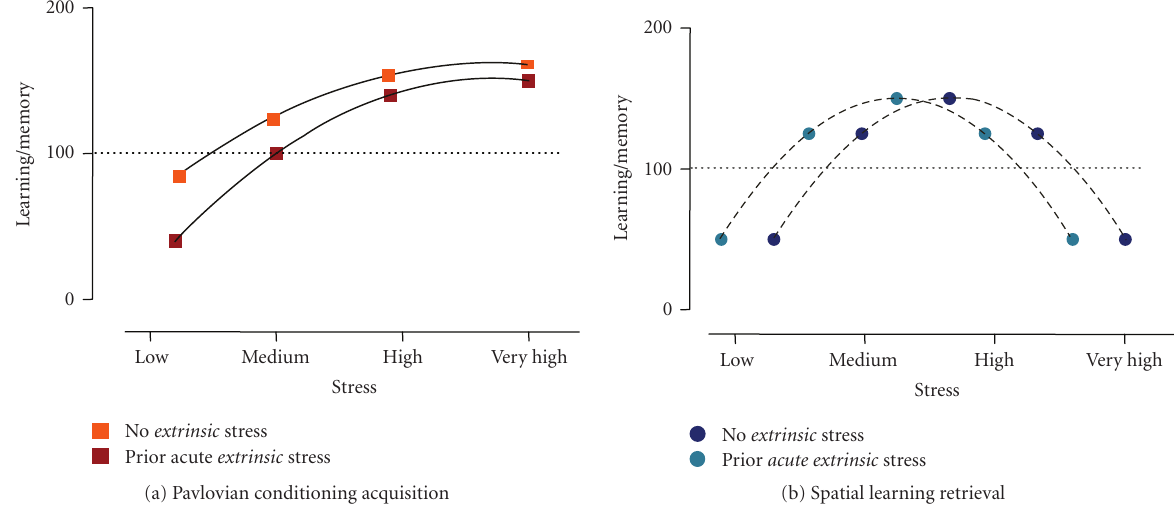
Figure 4: Impact of “acute extrinsic” stress on memory function. Figures representing how extrinsic stress can a ff ect the linear-asymptotic (a) and inverted U-shape (b) relationships depending on the intrinsic stress of each of the learning tasks. Note that, according to the available knowledge in the literature, this model accounts for the “acquisition” of Pavlovian conditioning (a) and for the “retrieval” of spatial infor- mation (b). In both conditions, extrinsic stress is proposed to displace to the left the relationship between stressor-related relationship and performance (however, this displacement in the case of the inverted U-shape in (b) has only been described for the right part of the curve).